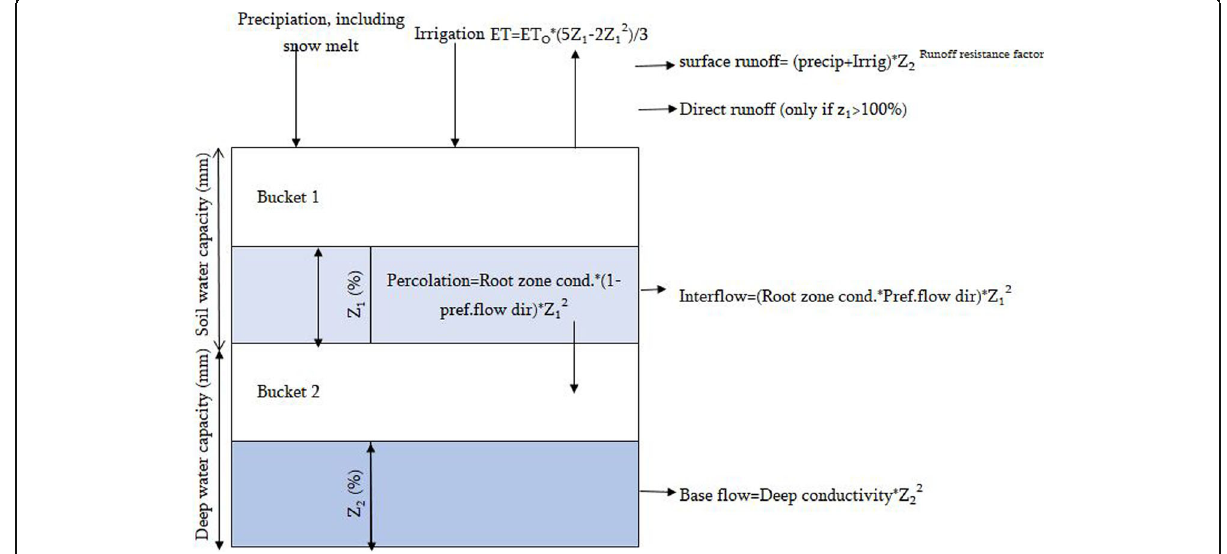
Fig. 2 Conceptual diagram and equations incorporated in the soil moisture model after (Sieber and Purkey